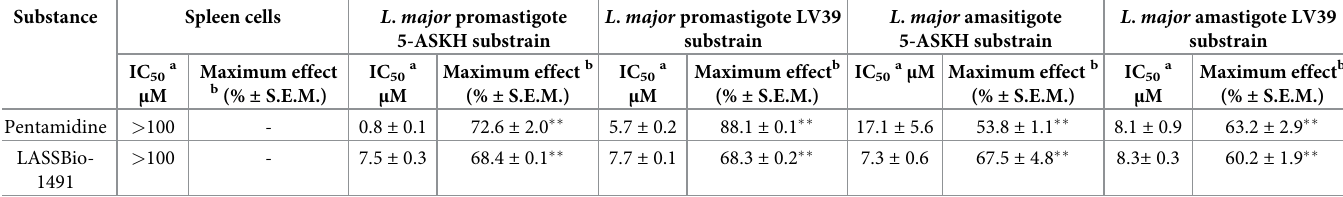
Table 5. In vitro cytotoxicity effect of pentamidine and LASSBio-1491 against spleen cells and promastigote forms of L . major . Substance Spleen